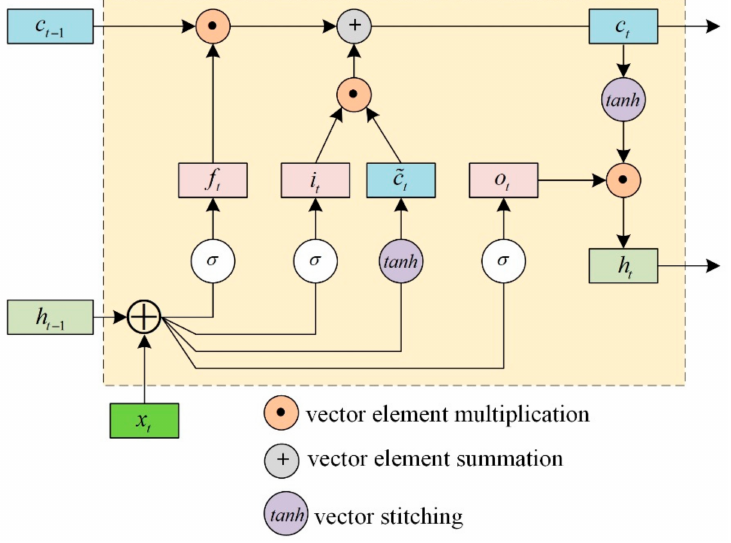
Figure 4. Recurrent structure of LSTM